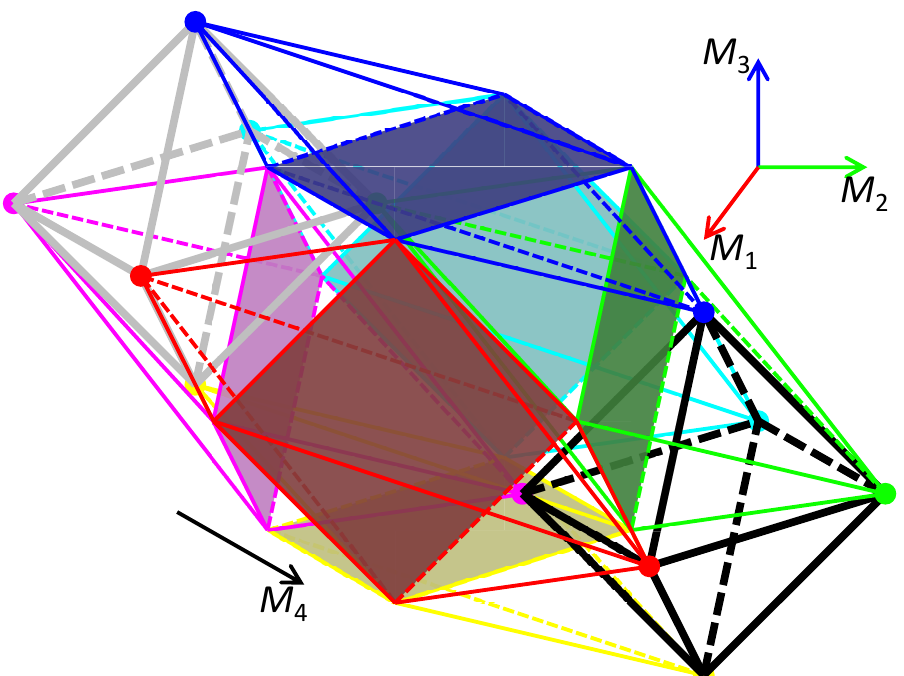
Figure 8 . Four-dimensional 24-cell consisting of 24 cells, 96 edges and 24 vertices. We specialize the direction of M . The vertices in M = ± k form the octahedra, while the vertices in M = 0 4 4 4 form the cuboctahedron. We depict the octahedra in black fat lines, while the cuboctahedron with color faces. Differences between solid and dashed lines do not make much sense visually (since it is four-dimensional). Aside from those in M = ± k , the remaining 22 boundary octahedra are 4 given by the following two types. 6 of them connecting the corresponding vertices and squares spread among the three polyhedra (depicted in various colors), while 16 of them connecting the corresponding triangular faces in two adjacent polyhedra (with each 8 connecting faces of the central cuboctahedron and each octahedron, not depicted to avoid